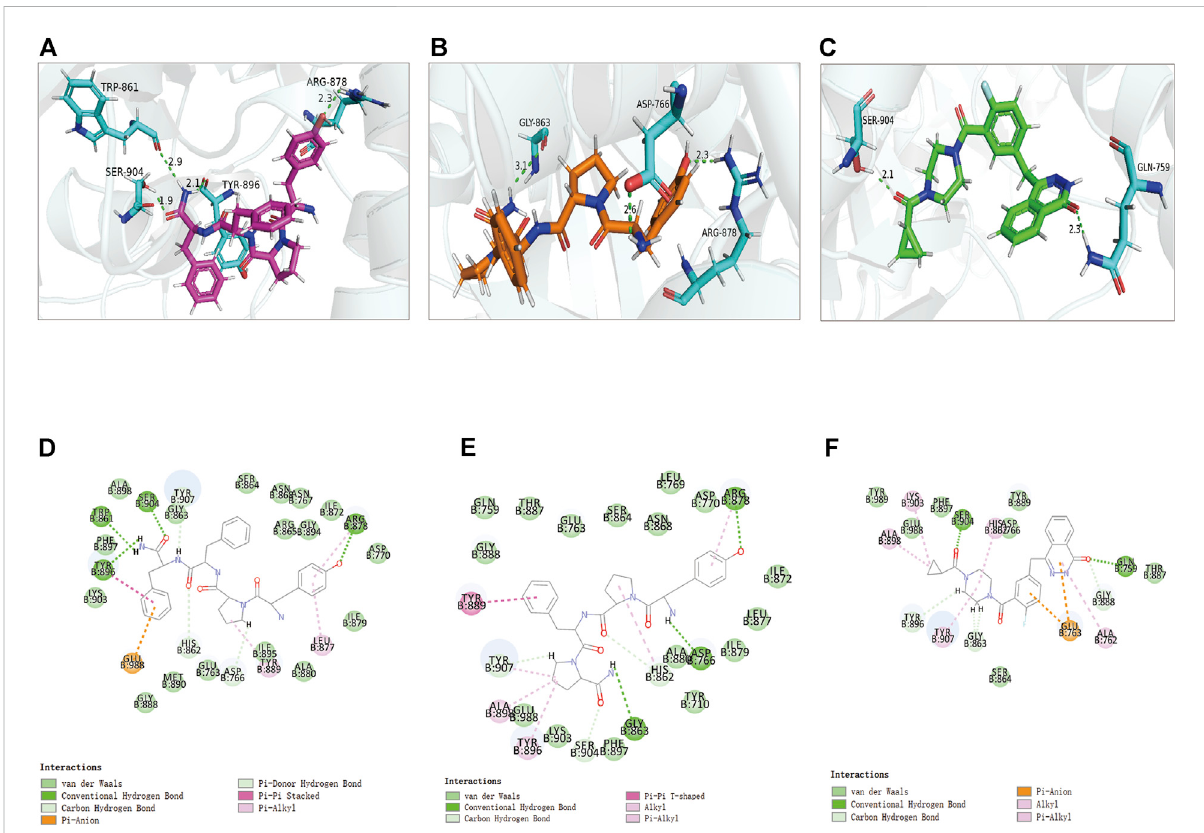
FIGURE 7 The 3D and 2D intermolecular interactions in the binding pockets by Schrodinger and PyMol of ligand-PARP-1 complex. Green represents Hydrogen bond. (A – D) ZINC000014951634- PARP-1 complex; (B – E) ZINC000053057130- PARP-1 complex; (C – F) Lynparza -PARP-1 complex.